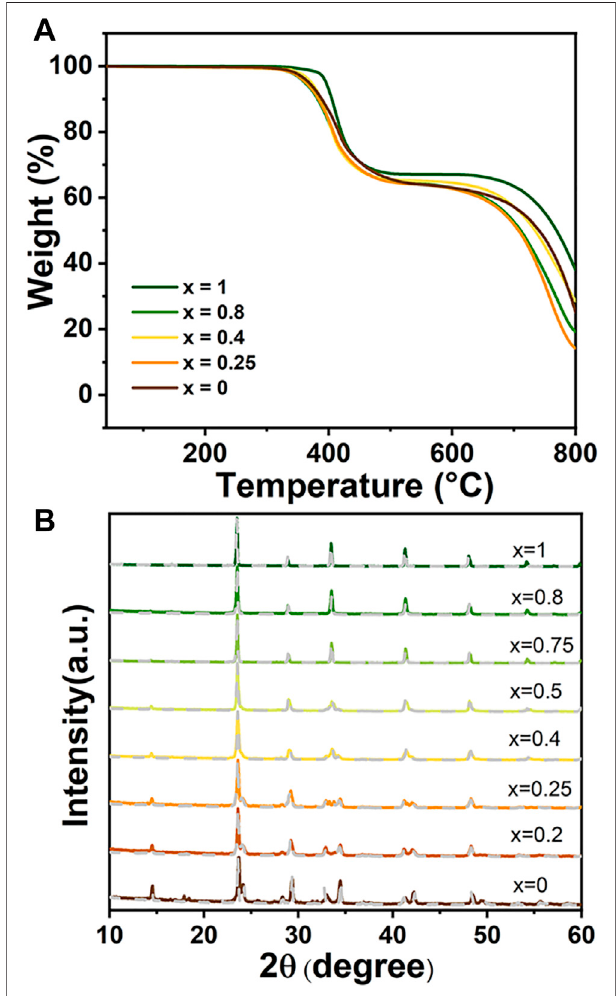
FIGURE 4 | (A) TGA of Cs 4 Cu 1-x Ag 2x Sb 2 Cl 12 (x = 0, 0.2, 0.4, 0.8, 1) SCs. (B) XRD patterns of as-synthesized Cs 4 Cu 1-x Ag 2x Sb 2 Cl 12 (x = 0, 0.2, 0.4, 0.8, 1) SCs (gray dashed line) compared to corresponding samples after exposure to ambient air for 3